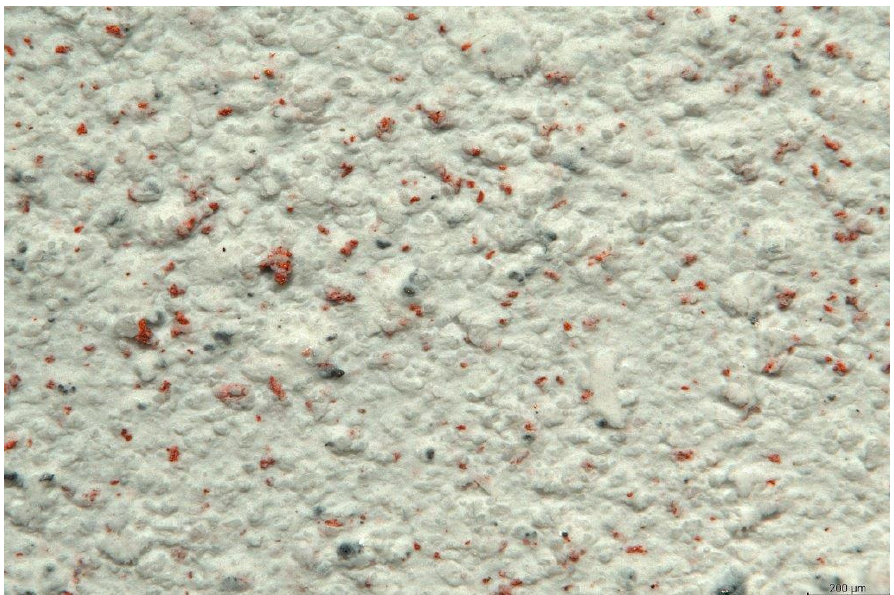
Figure 9. Paint surface, cross section, visible metal grains on undulate surface, scale bar = 200 μ m, Alcor R&D Center unpublished report, project No. POIR.01.01.01.00-636/20.